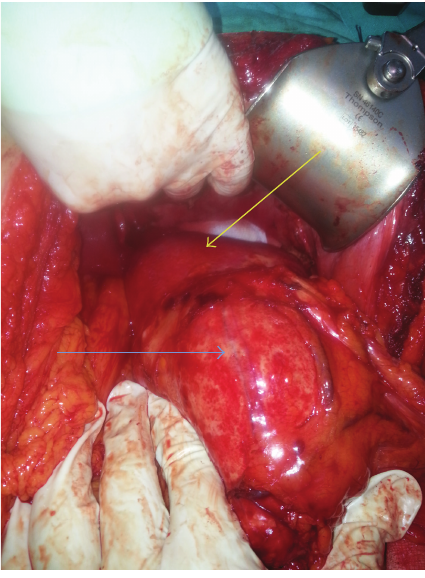
Figure 2: A large cystic mass that is attached to the left liver lobe (yellow arrow shows the left liver lobe and blue arrow shows the cystic mass).